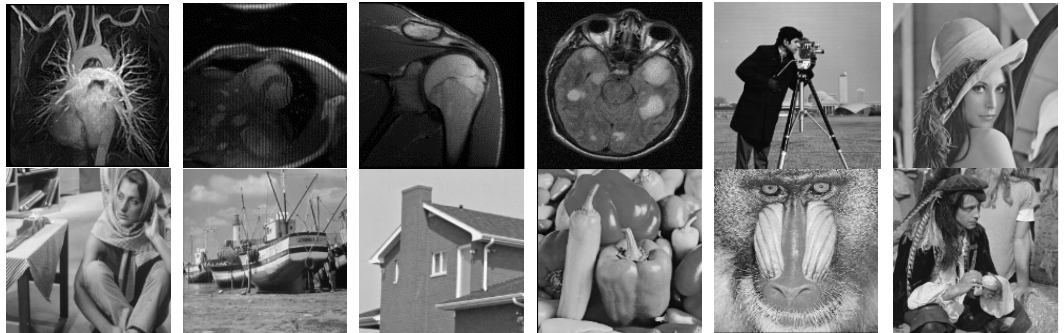
Figure 1. Twelve experimental test images.